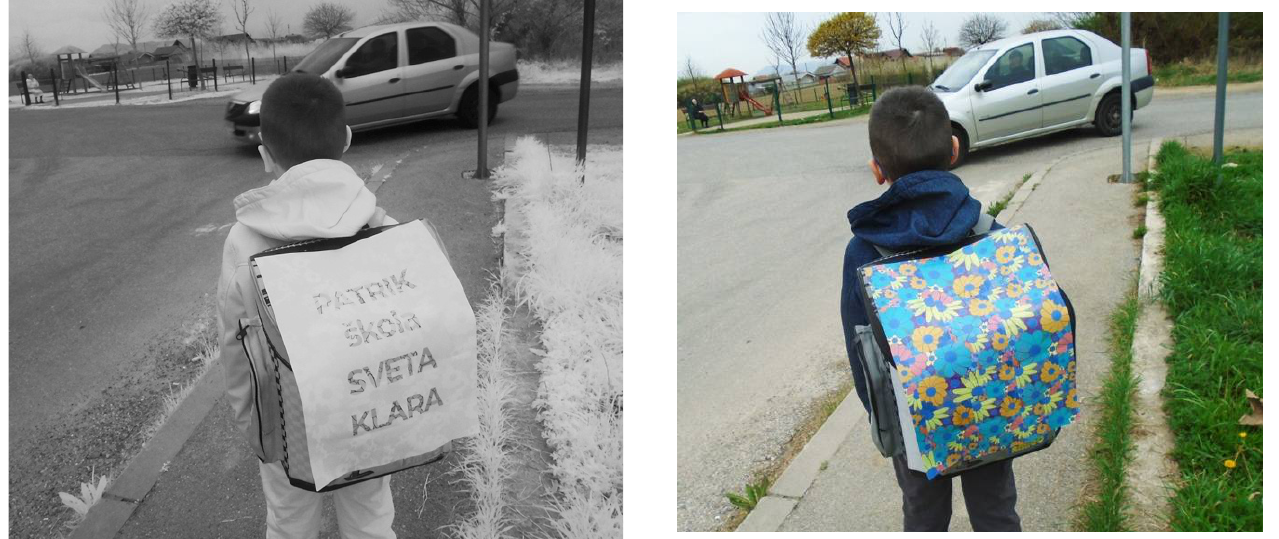
Figure 2. A boy on the street with a hidden mark (ZRGB camera).